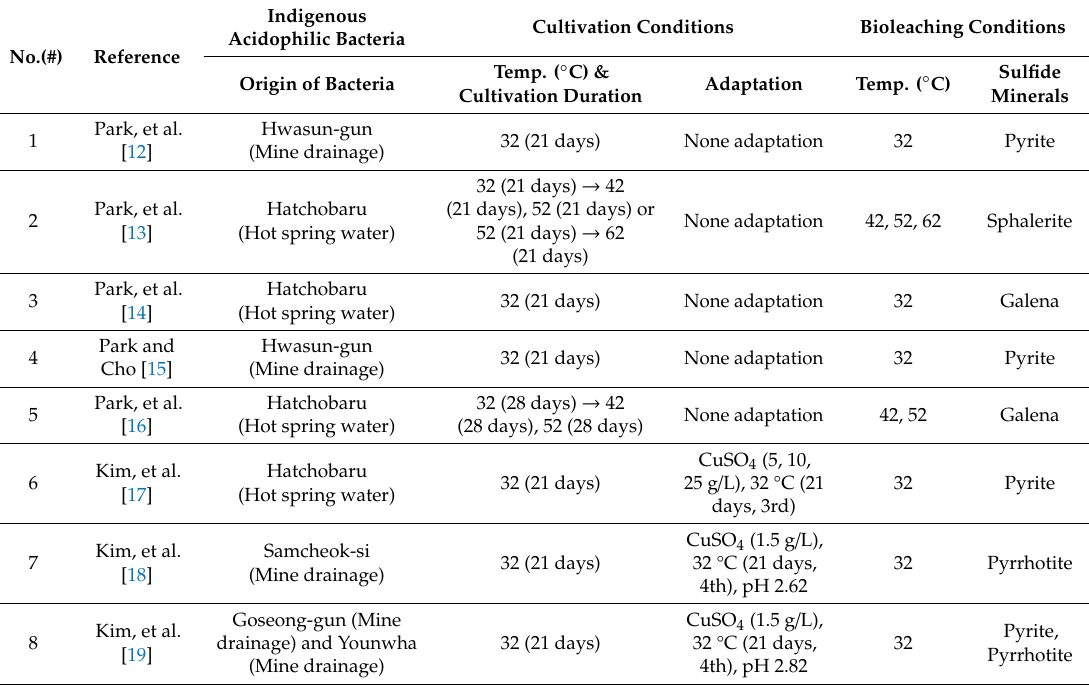
Table 1. Information on indigenous acidophilic bacteria sampling and cultivation of reference